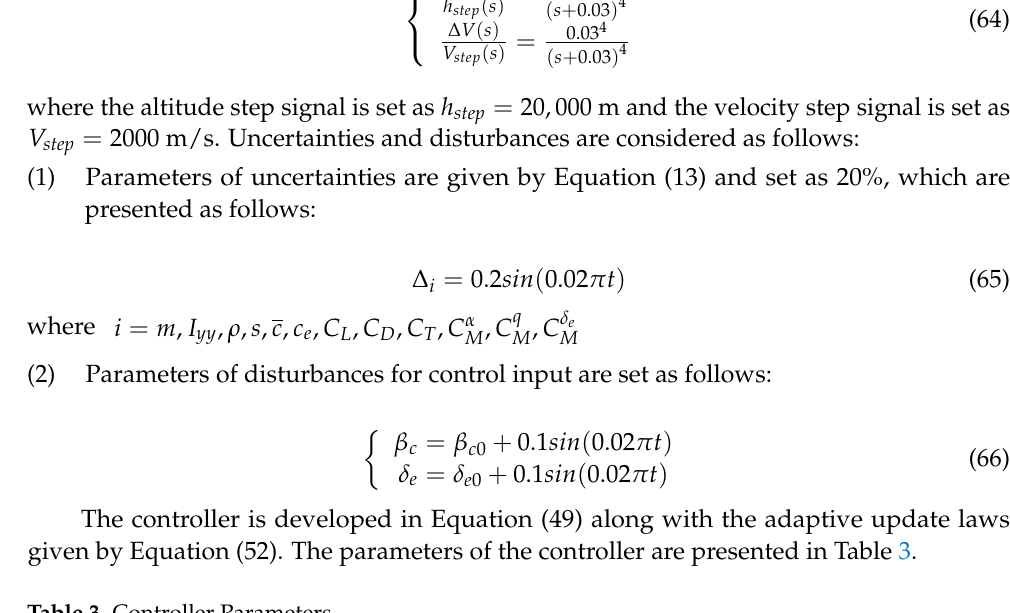
Table 3. Controller